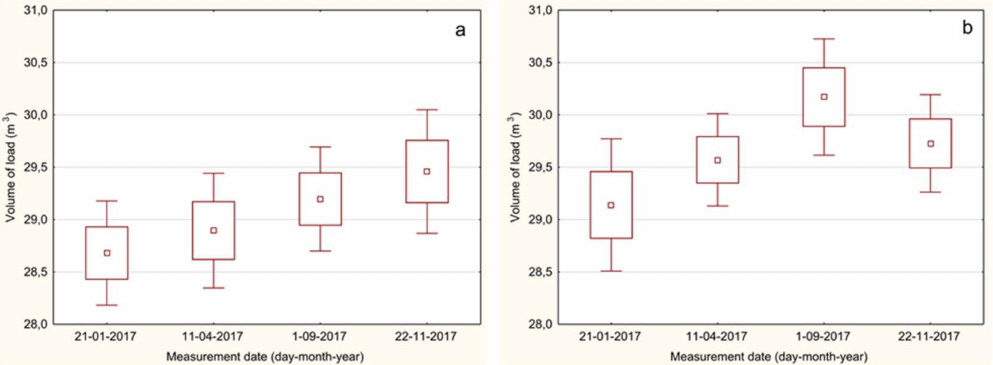
Figure 5. Comparison of average weight of 1 m 3 of load values by measurement date for a unit with a semi-trailer ( a ) and a trailer ( b ).